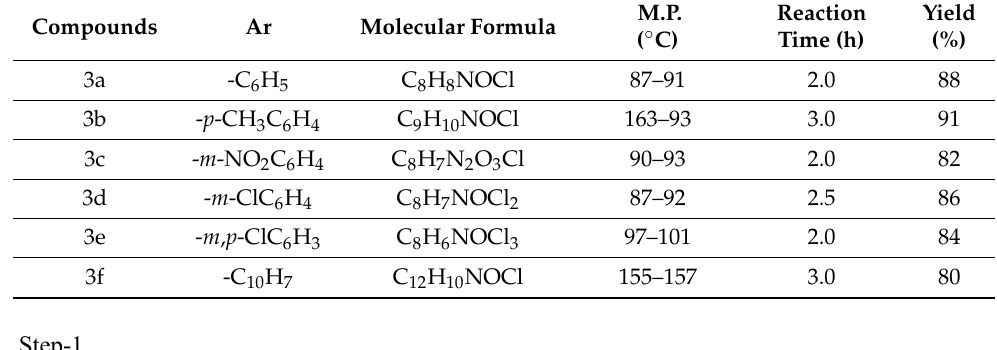
Table 1. Characterization data of the compounds 3a–f . Compounds Ar Molecular Formula